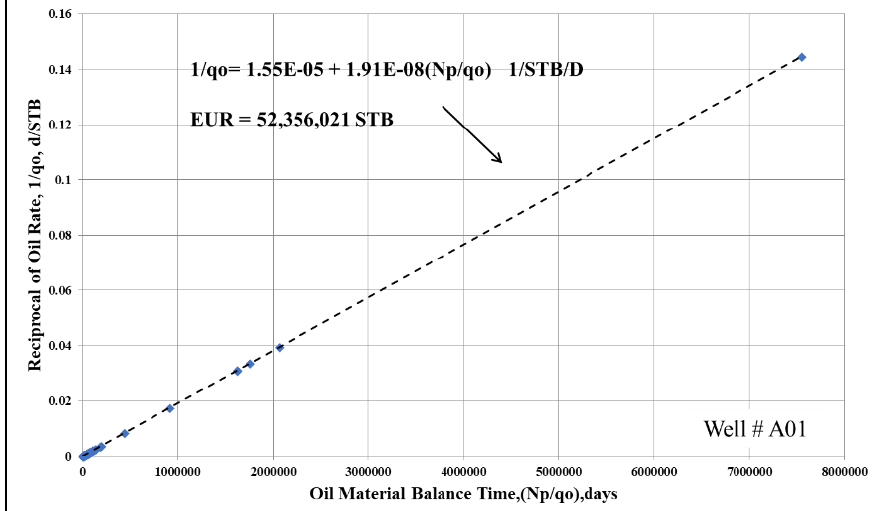
Figure 8. Reciprocal of oil rate, 𝟏/𝒒 𝒐 versus oil material balance time, to for well A01